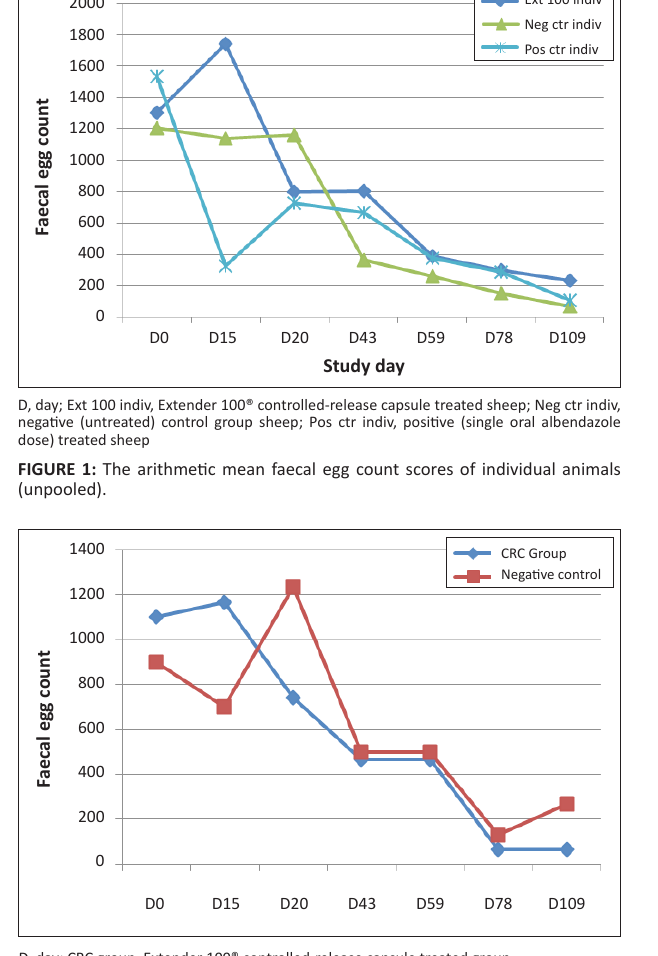
FIGURE 2: Mean bulk (pooled) faecal egg counts of two groups during the